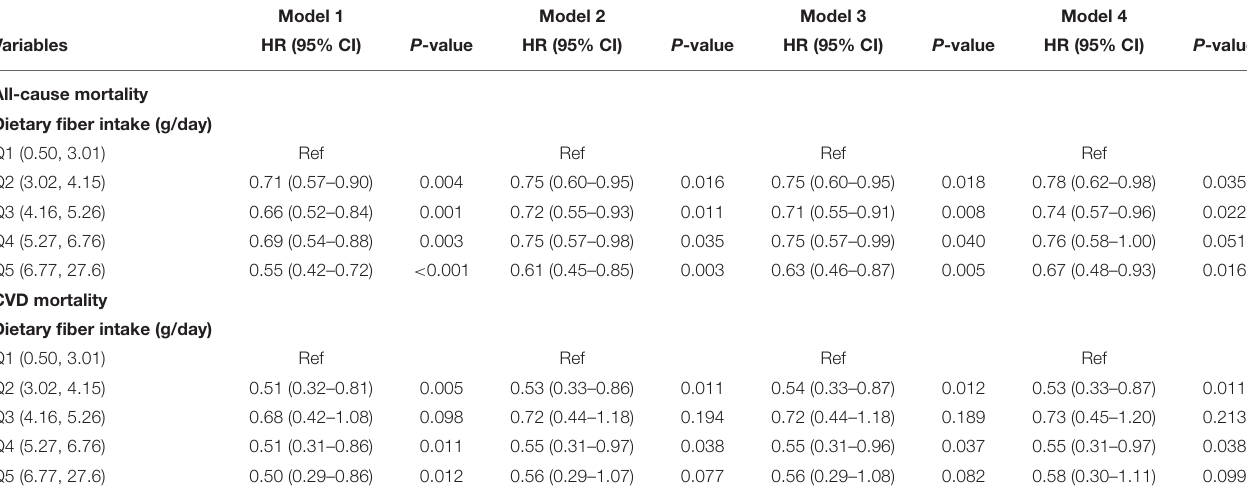
TABLE 2 | Multiple cox proportional hazard regression analysis of dietary fiber intake quintiles for all-cause mortality and cardiovascular